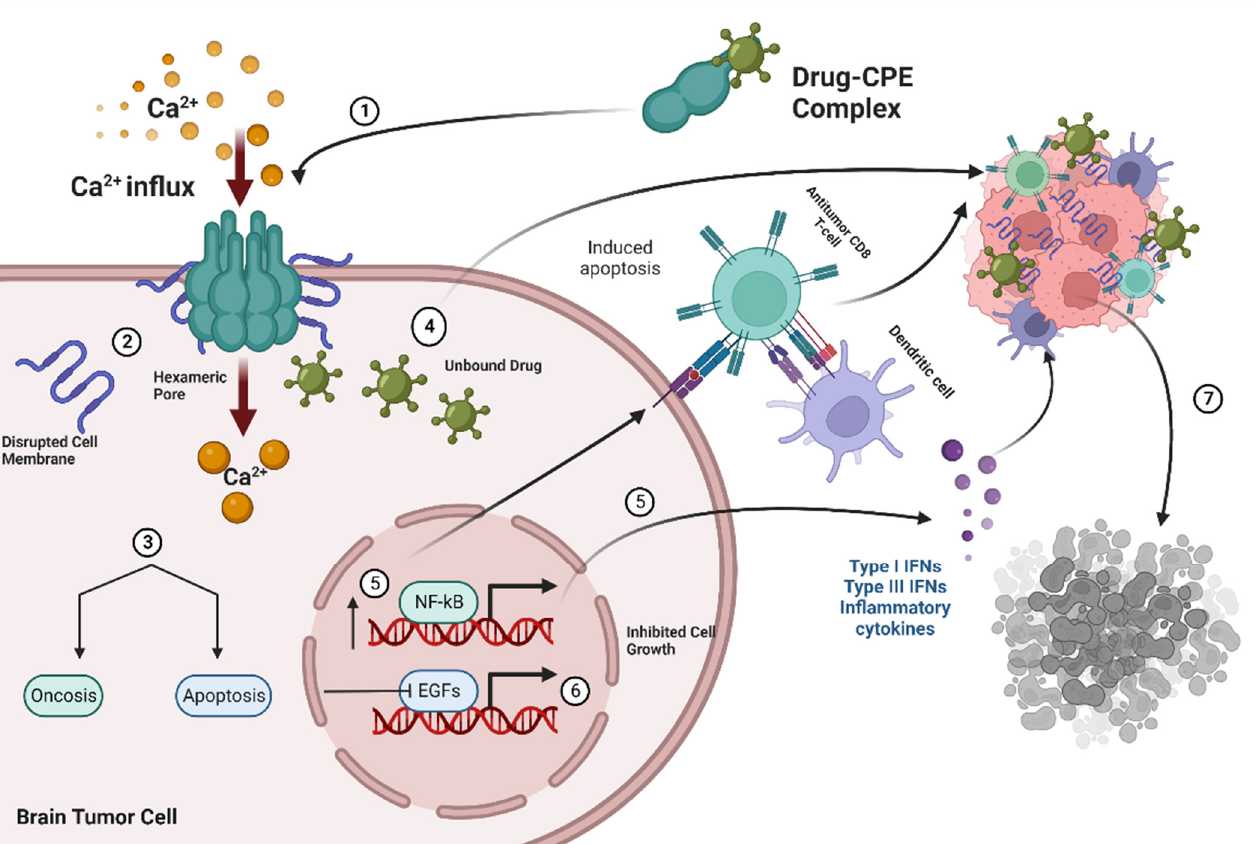
Figure 2. ( 1 ) Drug–CPE complex interacts with Claudin-4 receptors in brain metastatic tumor cells and forms a hexameric pore causing increases in influx of Ca 2+ , osmotic dysregulation, and membrane disruption ( 2 ), which leads to apoptosis or oncosis ( 3 , 4 ). Unbound drugs are delivered into tumor cells and further mediate cell destruction upon binding by exerting antitumor effects on cancer cells while ( 5 , 6 ) the modulation of growth factor signaling and nfKB increase cell death by decreasing cell proliferation and increasing expression of inflammatory cytokines and immune cells ( 7